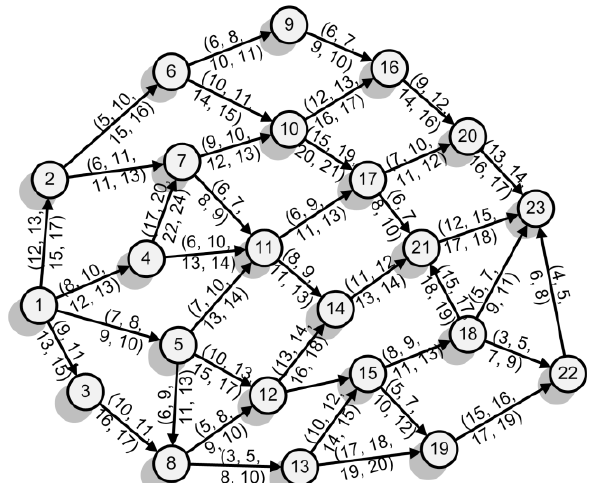
Figure 3. Examined network with 23 nodes (The station IDs are reported on every node, while edge values demonstrate cost of the paths in terms of triangular fuzzy values )